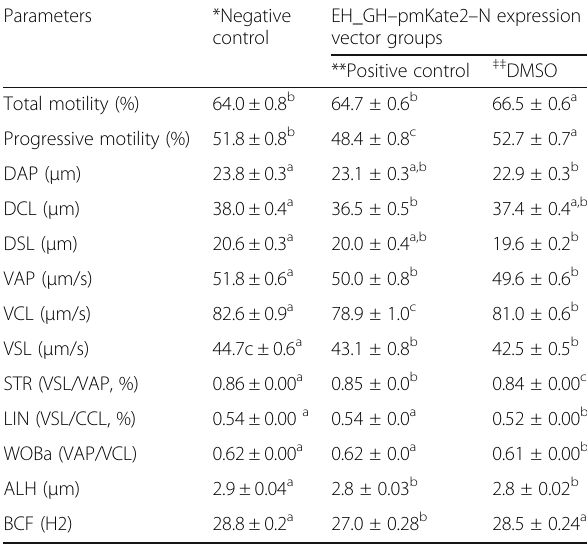
Table 1 Effect of the EH_GH – pmKate2 – N vector uptake on sperm motility (mean ± SEM)